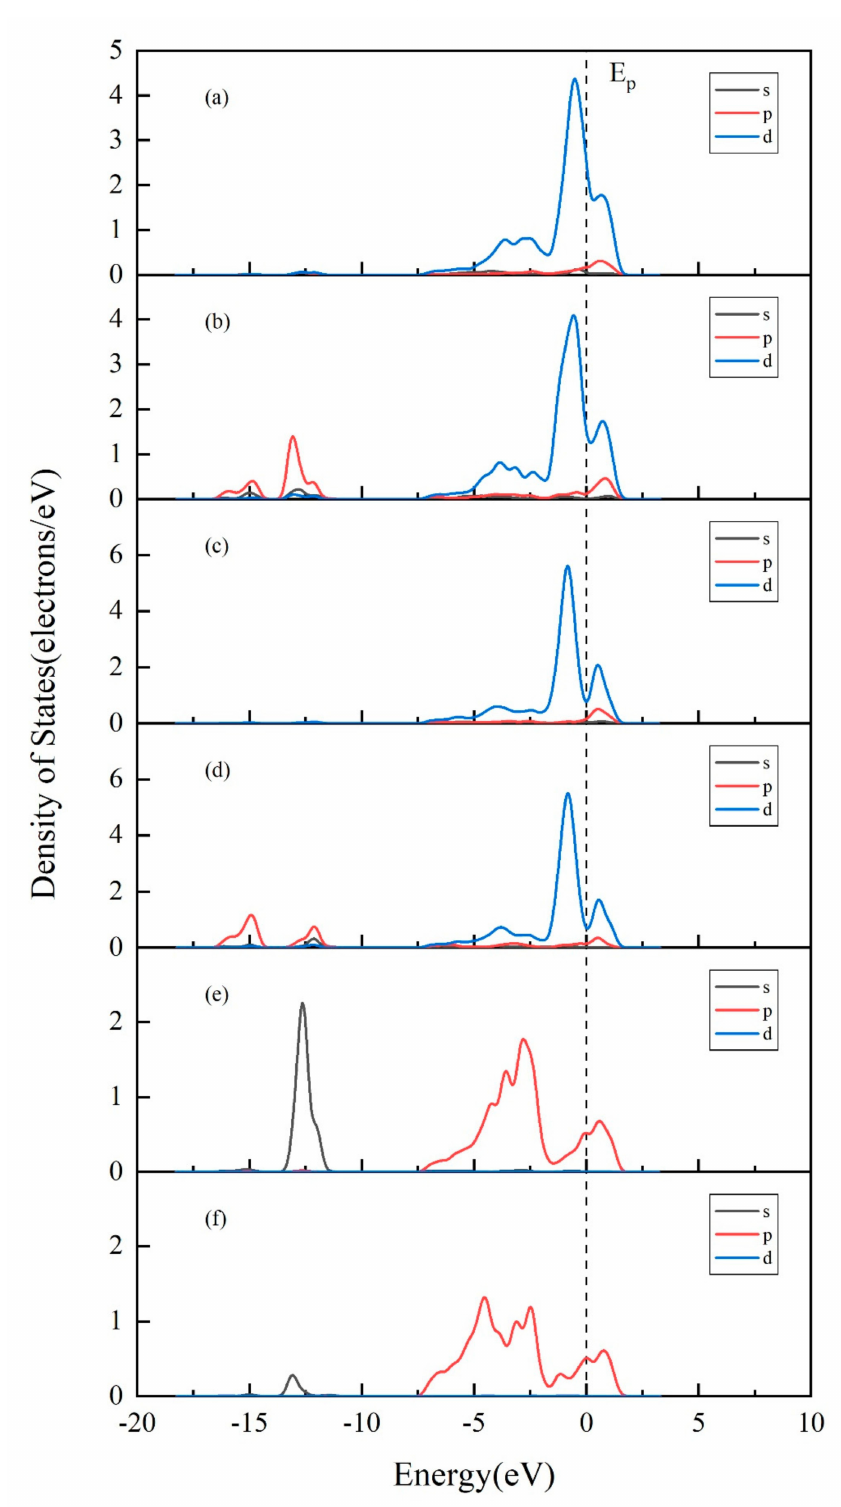
Figure 5. The PDOS plots of atoms before and after Au adsorption on pyrite (210) surface: ( a , b ) are PDOS before and after adsorption of Fe1 atoms on the surface of pyrite (210); ( c , d ) are PDOS before and after adsorption of Fe2 atoms on the surface of pyrite (210); ( e , f ) are PDOS before and after adsorption of S2 atoms on the surface of pyrite